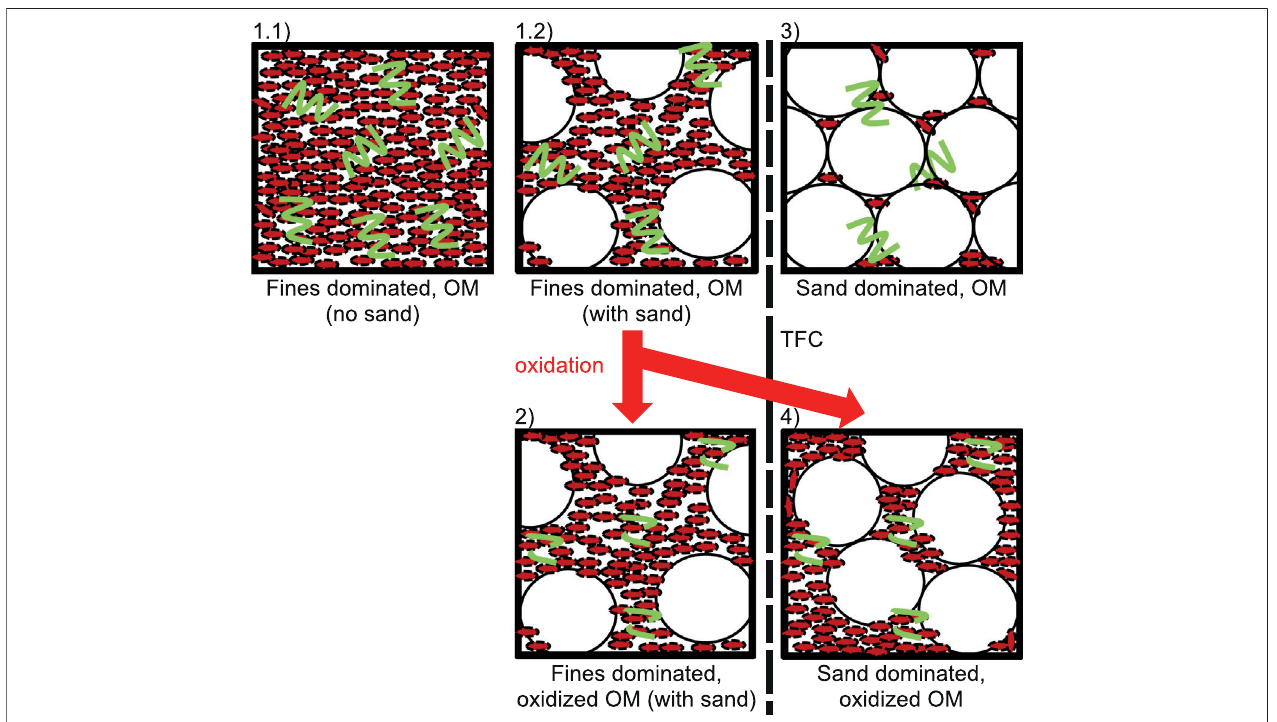
FIGURE 5 | Schematic of mechanical behavior of the studied sediment as a function of its composition. Legend: curly lines represent OM, dashed curly lines represent oxidized OM, small oval particles represent fi nes, and big round particles represent sand.